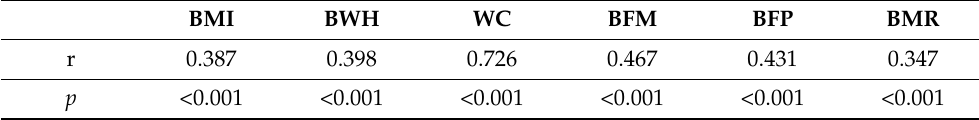
Table 4. Correlations between HOMA-IR score and anthropometric